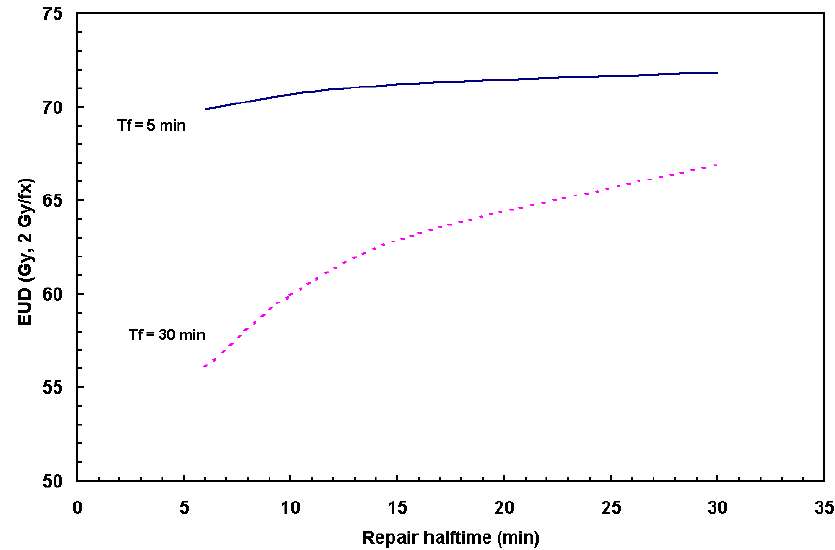
Figure 4. The variation of EUD as a function of repair halftime T delivery time of 5 min (dashed) and 30 min (solid) were shown. The standard fraction scheme was considered in the calculation: 70 Gy in 2